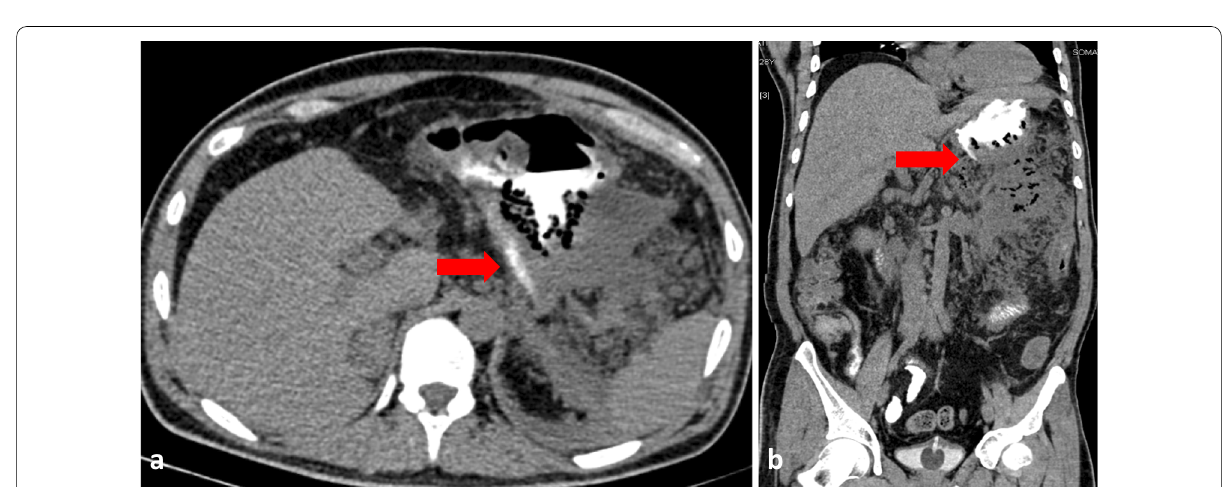
Fig. 2 Computed tomography axial ( a ) and coronal ( b ) images showing extravasation of oral contrast through the stomach wall defect (red arrow)